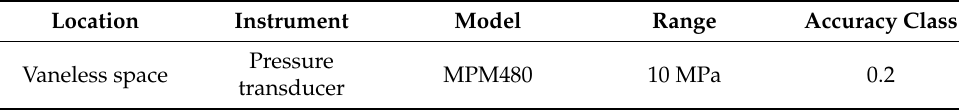
Table 2. Measurement parameters of the pressure